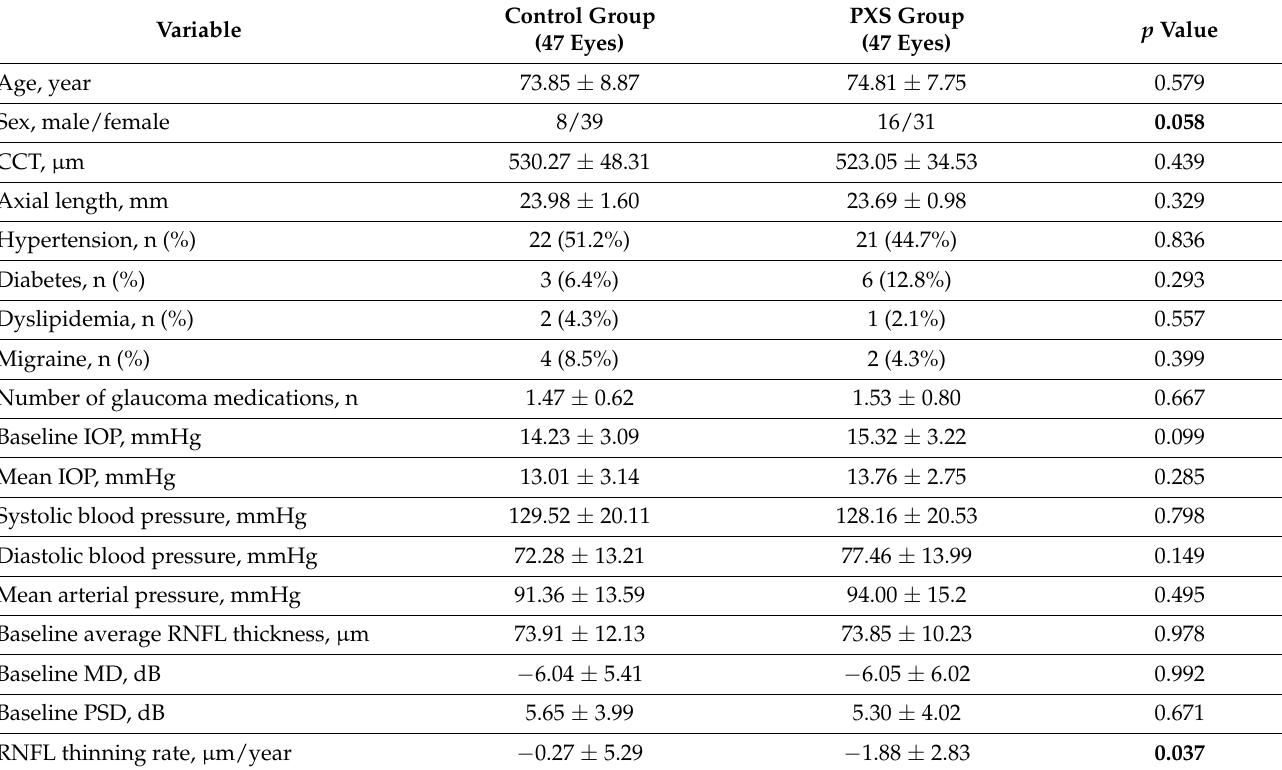
Table 2. Differences in demographic and clinical characteristics between patients with NTG with PXS and those without